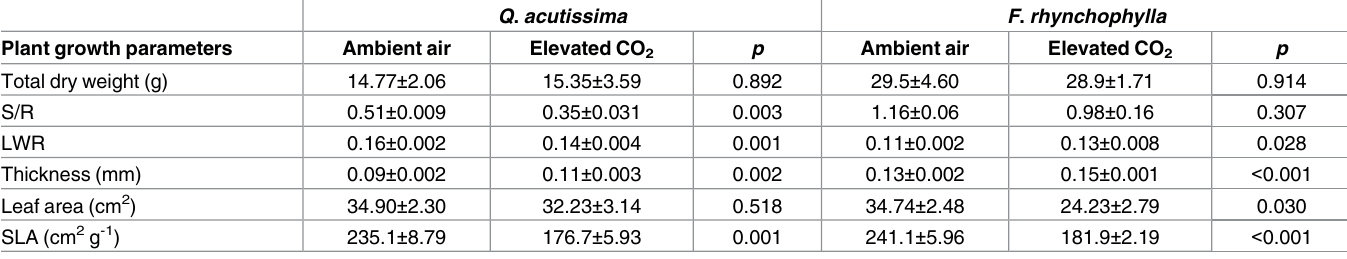
Table 1. Comparison of the growth parameters of Q . acutissima and F . rhynchophylla in the ambient air (380 ppm) and elevatedCO 2 (700 ppm)